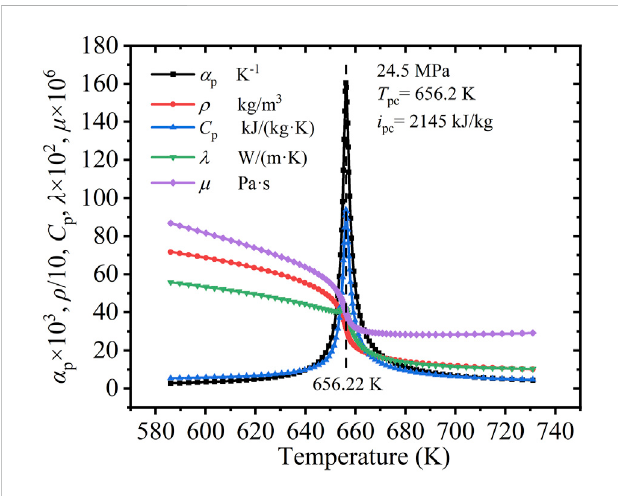
Variations in thermophysical properties of water ( p = 24.5 MPa, T pc = 656.2